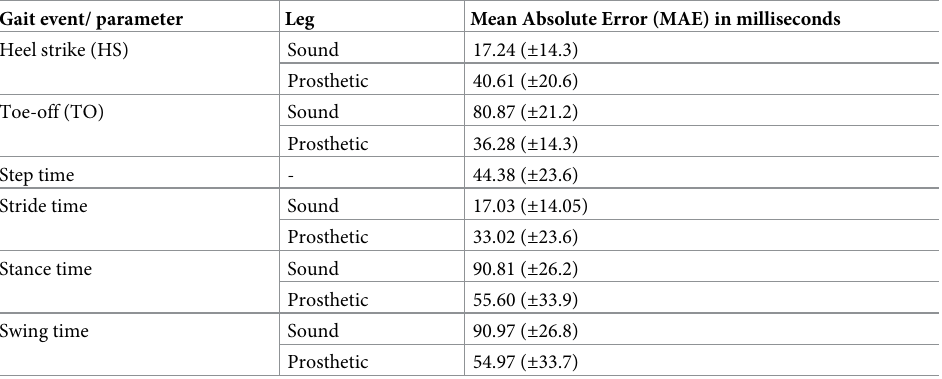
values were plotted against the walking speed for gait events as well as stance/swing time (c.f. Fig 4). The error values are normalized by stride duration for a meaningful comparison across Table 3. Absolute error values for gait events and